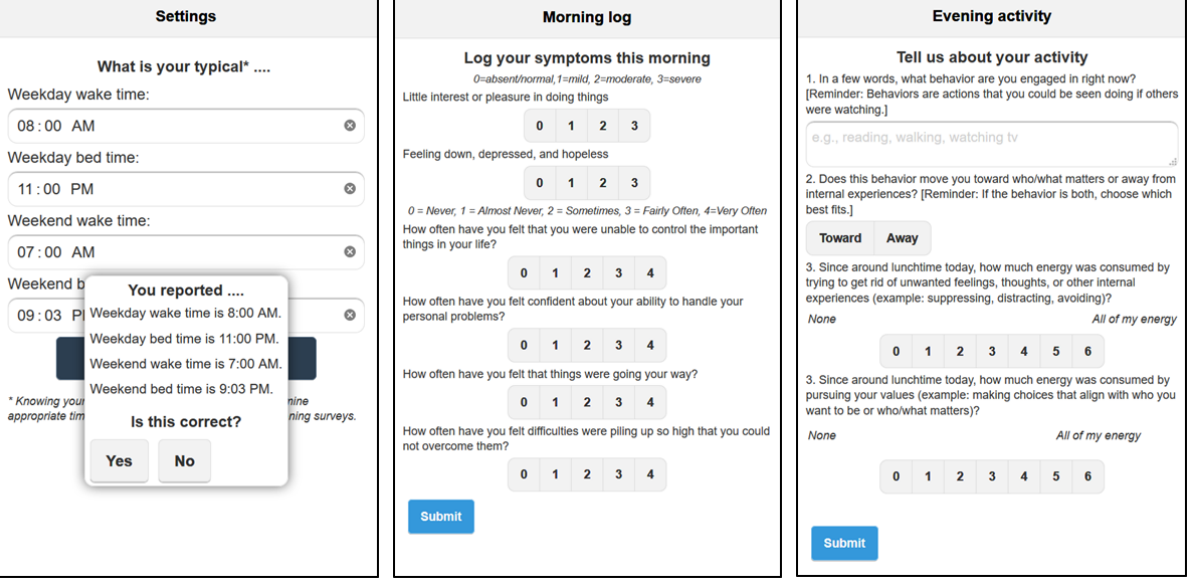
Figure 2. Log functions of the Lorevimo app. The first screen (left) is where participants can set regular weekday and weekend wake times and bedtimes, which determines when they are prompted to log symptoms and activities. The second screen (center) is the mood symptoms log, including depression symptoms and perceived stress. The third screen (right) is the activity